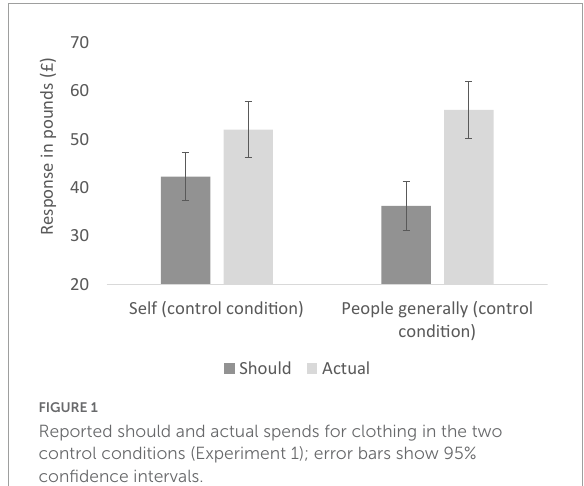
FIGURE1 Reported should and actual spends for clothing in the two control conditions (Experiment 1); error bars show 95% confidence